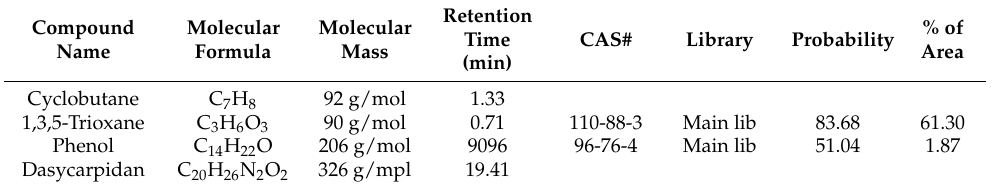
Table 7. Major constituents of bacterial extract H3(A1S6) were identified by GC–MS analysis.